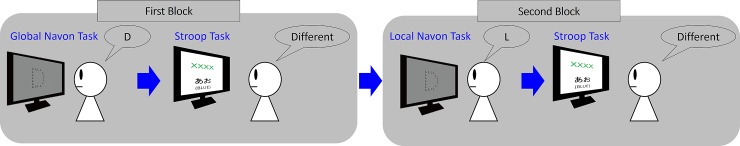
Experimental design.All participants engaged the global condition and the local condition. The order of the conditions was counterbalanced. In each condition, after the Navon task, they completed the Stroop task. Each condition contained either the global or the local Navon task.